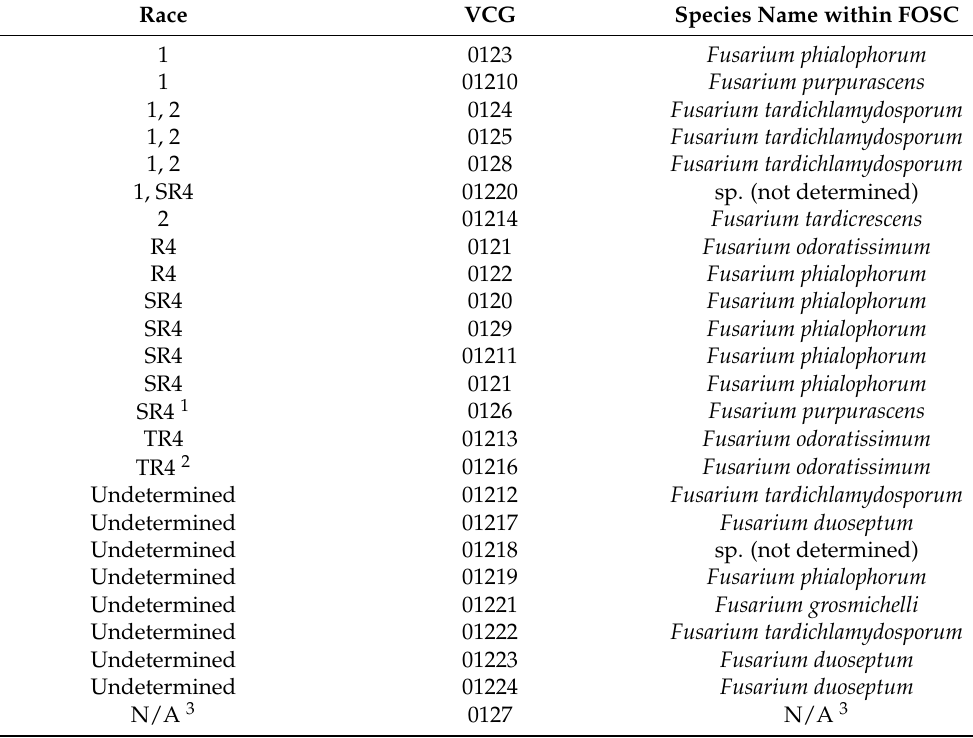
Table 1. A summary of taxonomic species and other methods of developed to classify Fusarium oxysporum f.sp. cubense , including race and vegetative compatibility group (VCG) species designation within the Fusarium oxysoprum species complex (FOSC)